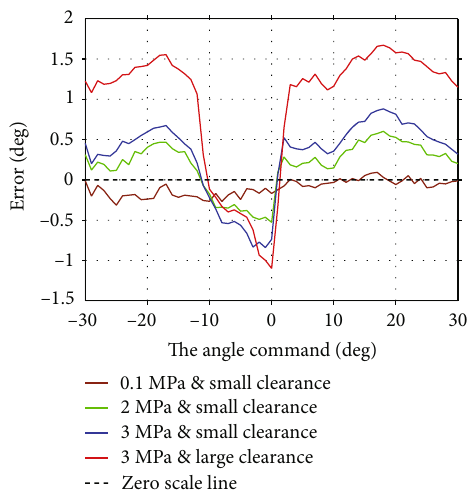
Figure 7: The error between valve angle and command.